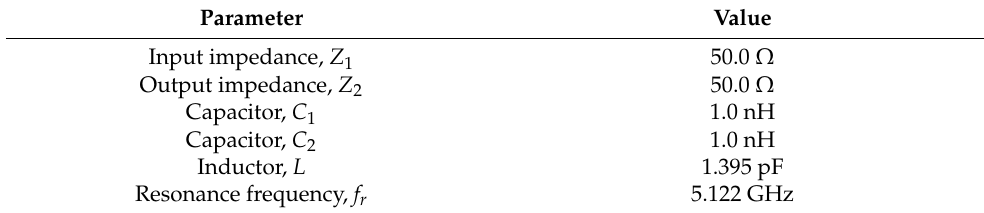
Figure 2. Design of ( a ) square ring resonator on a substrate and ( b ) equivalent circuit. Table 1. ADS simulation parameter for LC equivalent circuit.